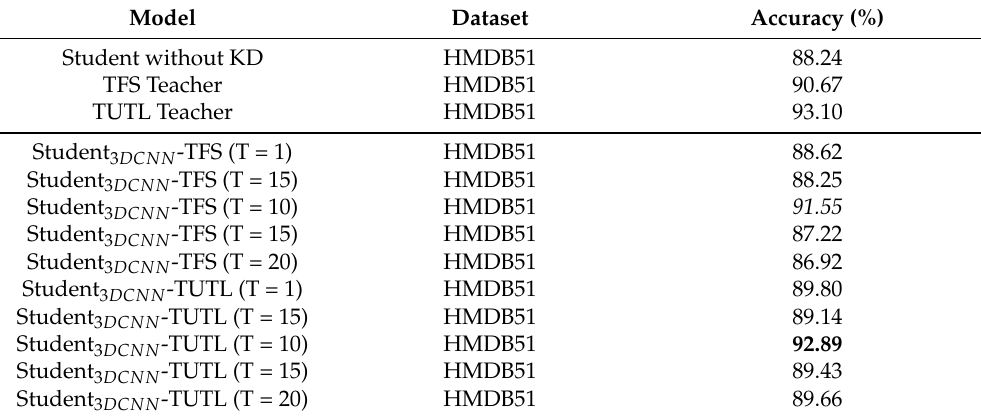
Table 4. Quantitative comparative analysis of the results obtained by our proposed framework with and without knowledge distillation (KD) with different settings over HMDB51 dataset.